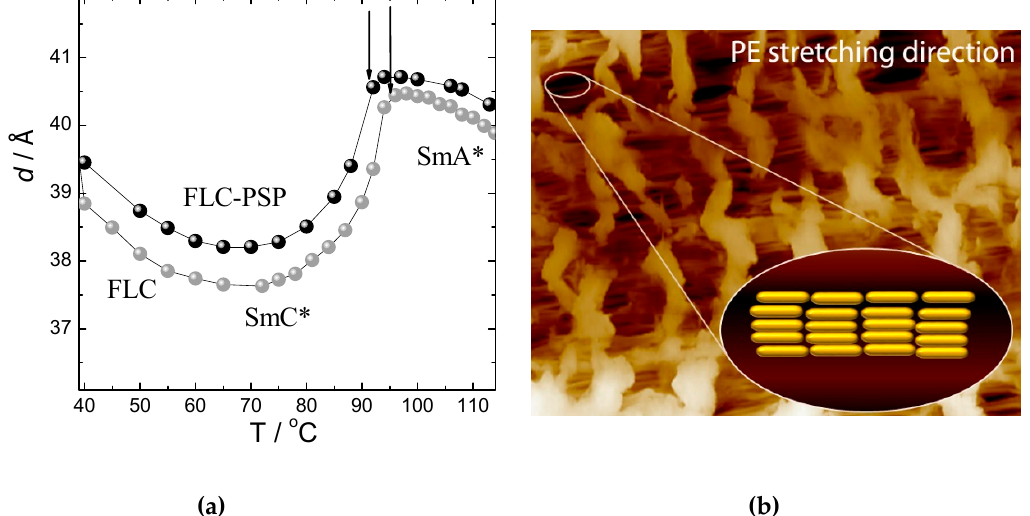
Figure 6. Temperature dependence ( a ) of the smectic layer spacing, d , for pure FLC compound (grey circles) and for the PE-FLC nanocomposite (black circles) measured on cooling. Vertical arrows indicate the SmA*-SmC* phase transition. The measurement error approximately corresponds to the size of symbols. ( b ) Schematic cartoon of the molecular orientation in SmA* phase inside the pores of the stretched PE film; stretching direction is horizontal; rods stacked in layers represent the FLC molecules oriented along the stretching direction of the PE film. Figure 7. Conformation of the FLC molecule used for the PE-FLC nanocomposite after energy minimization using MOPAC/AM1 method. The length of the most extended conformer is 38.5 Å.